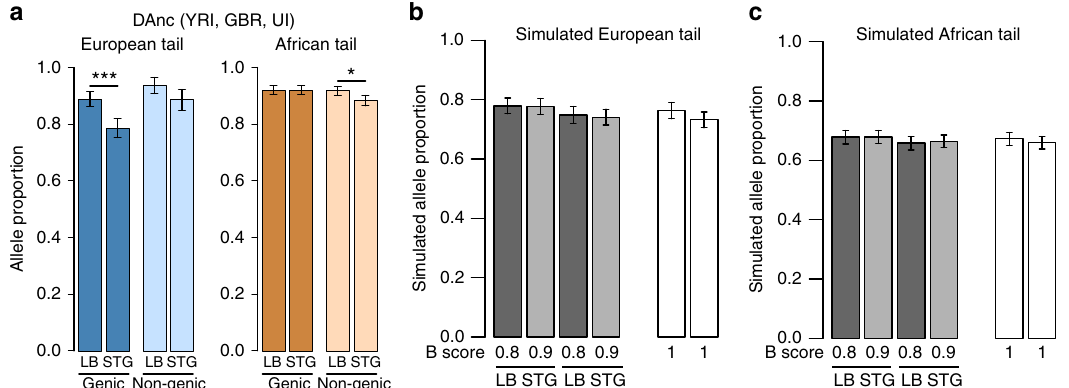
Figure 4 | Analysis of the presence of European DAnc tail alleles in ancient European genomes. ( a ) Proportion of European alleles present in Loschbour (LB) or Stuttgart (STG) among those in the tails of the DAnc (YRI, GBR, Ust 0 -Ishim) distribution. Bootstrapping provided confidence intervals (95% confidence interval shown) and asterisks indicate significant differences between LB and STG (* P o 0.05, ** P o 0.01 and *** P o 0.001). ( b , c ) Expectation of these proportions in the ( b ) European or ( c ) African tails, in the absence of adaptive evolution and with various intensities of background selection (measured by B scores). Genic alleles are simulated with B o 1, and non-genic alleles with B ¼ 1. The 95% confidence interval shown is obtained via